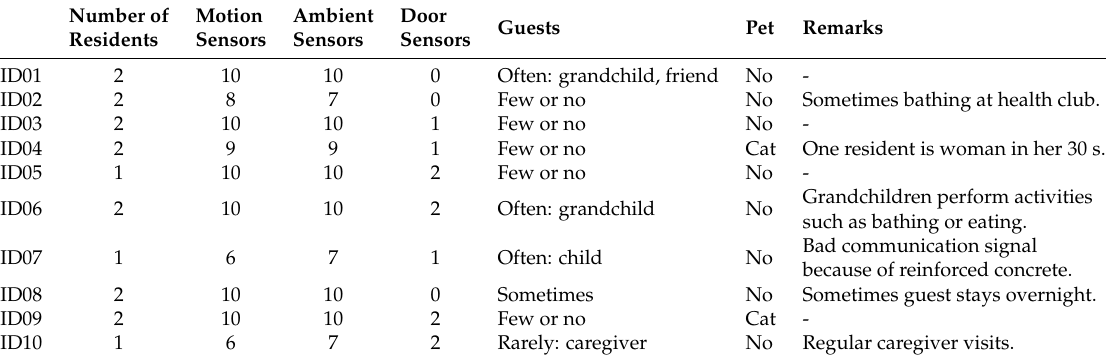
Table 2. Specifications for each